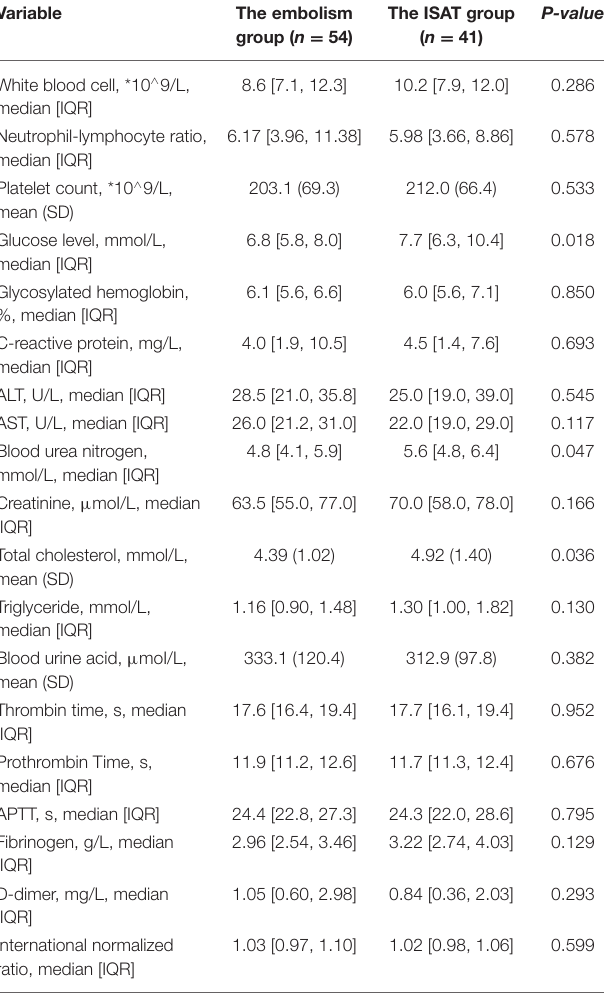
TABLE 1 | Demographics and clinical characteristics between the in situ atherosclerotic thrombosis group and the embolism group. Variable